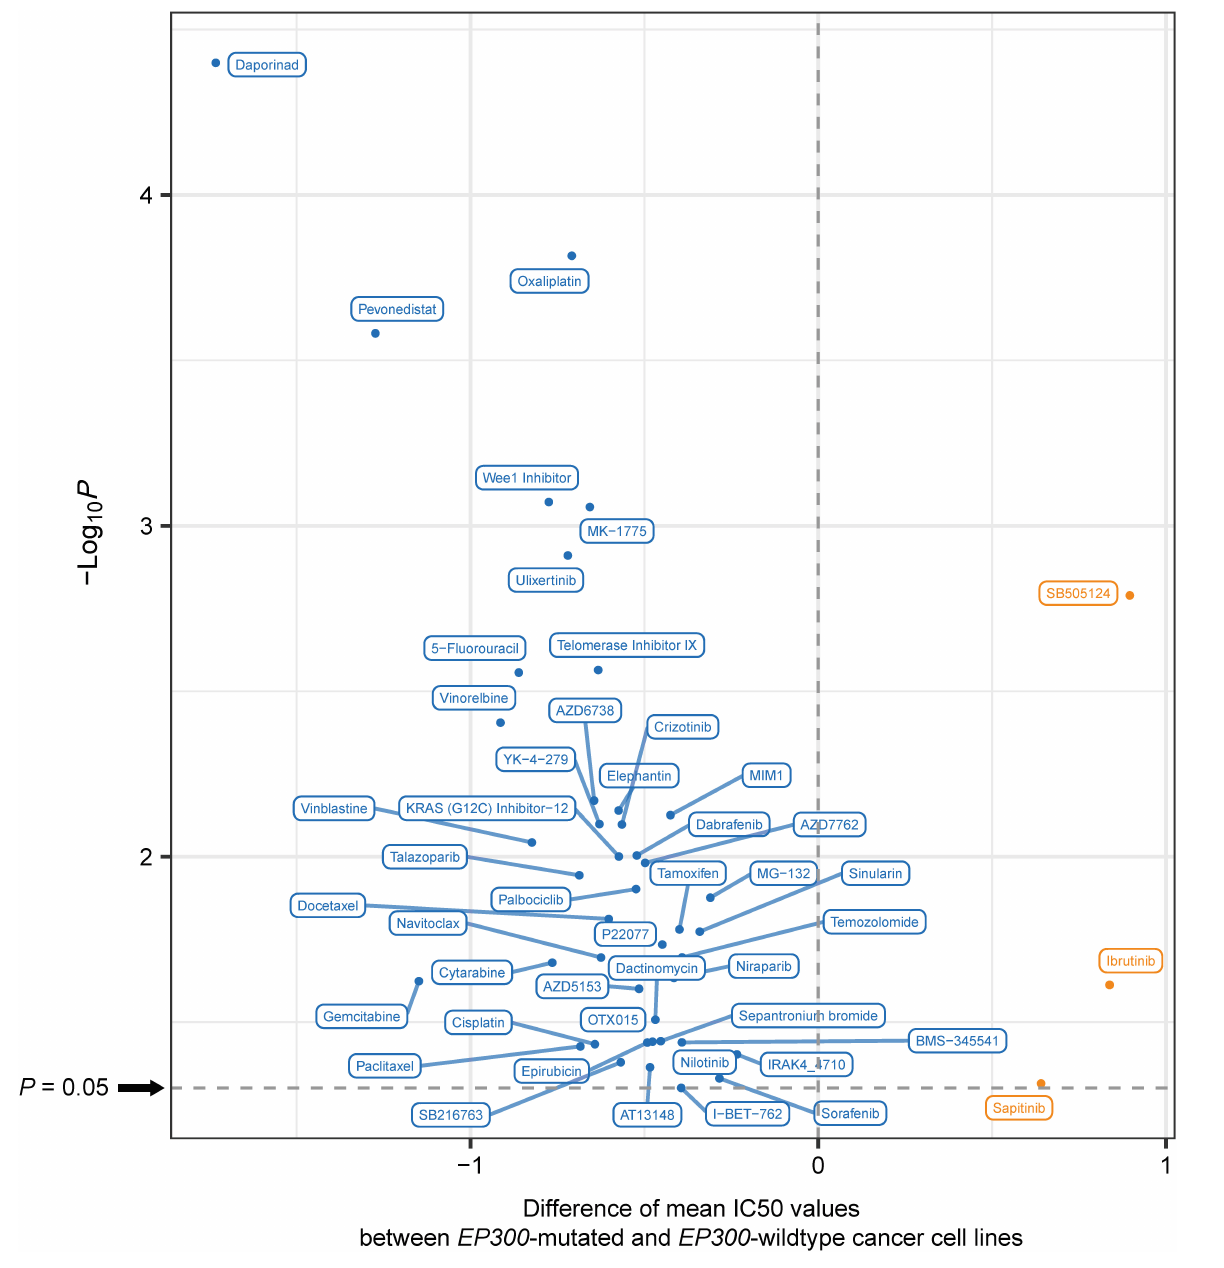
FIGURE 5 | The compounds to which E1A binding protein p300 ( EP300 )-mutated and EP300 -wild-type cancer cell lines have significantly different sensitivities. Blue indicates higher sensitivity (lower IC50 values) in EP300 -mutated cell lines, and red indicates higher sensitivity (higher IC50 values) in EP300 -wild-type cell lines (one-tailed Mann–Whitney U test, p <